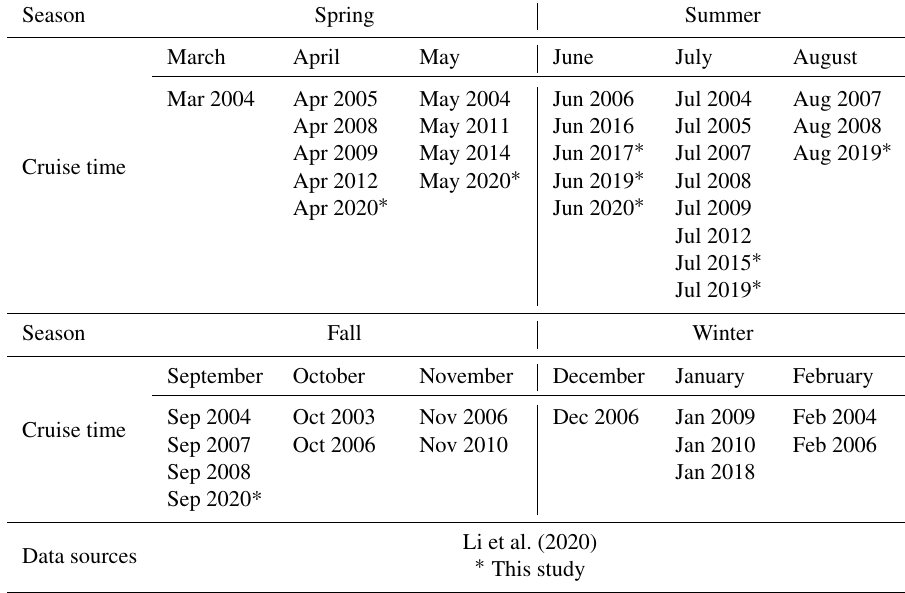
Table 1. Summary of seasonal in situ data of sea surface p CO 2 in the South China Sea for the period 2003–2020 used in this study.